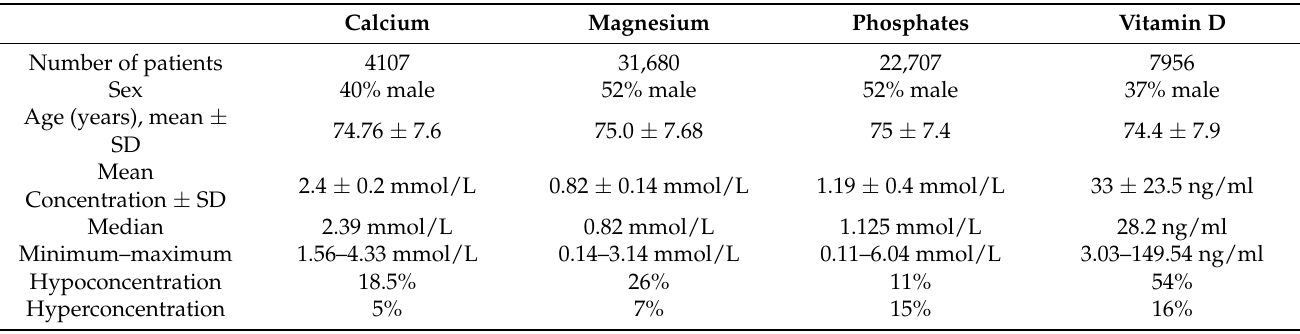
Table 2. Basic information regarding the study